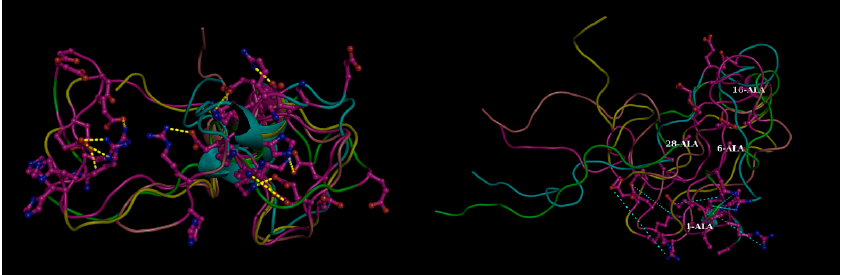
Figure 3. Effect of mutations in disordered proteins. Four transient (flitting) salt bridge forming charged residues (1-Asp, 6-His, 16-Lys, 28-Lys) mutated to alanine in beta amyloid (A β 42) resulting in the dismantling in salt-bridges globally throughout the structural ensemble (Left Panel: Mutant compared to the Right: Native). These transient salt-bridges continuously keep altering their partners throughout the whole simulation trajectory supporting different conformations at different time points and thereby supporting a conformational ensemble (illustrated in Figure 3. of Reference [19]). The yellow dashed lines in the left panel (native) show the salt-bridges found individually in the five randomly chosen conformers (within 4 Å) while the same connections are shown by thinner cyan dashed lines in the right panel to portray the absence of these ionic interactions (far greater than 4 Å). Molecular Dynamics simulation trajectories collected from Reference [19]. Briefly, explicit-water molecular dynamic (MD) simulation was performed with AMBER 12 at T = 300 K using the ff99SB force field with